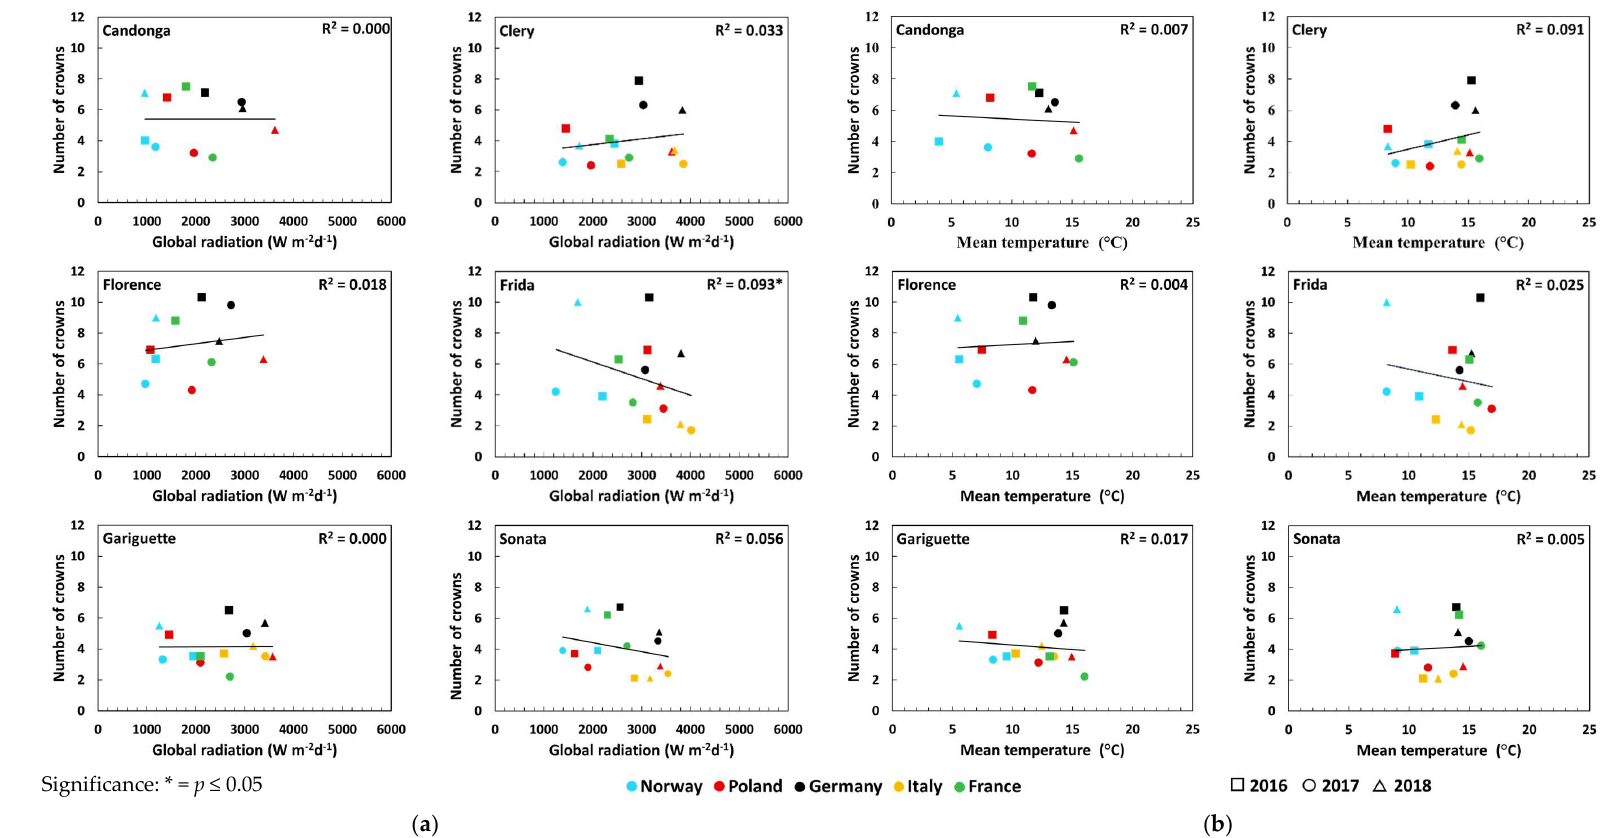
Figure 7. Number of crowns of six cultivars grown at five locations in Europe as influenced by ( a ) global radiation and ( b ) mean temperature during the 5-week period after flower initiation in 3 years.